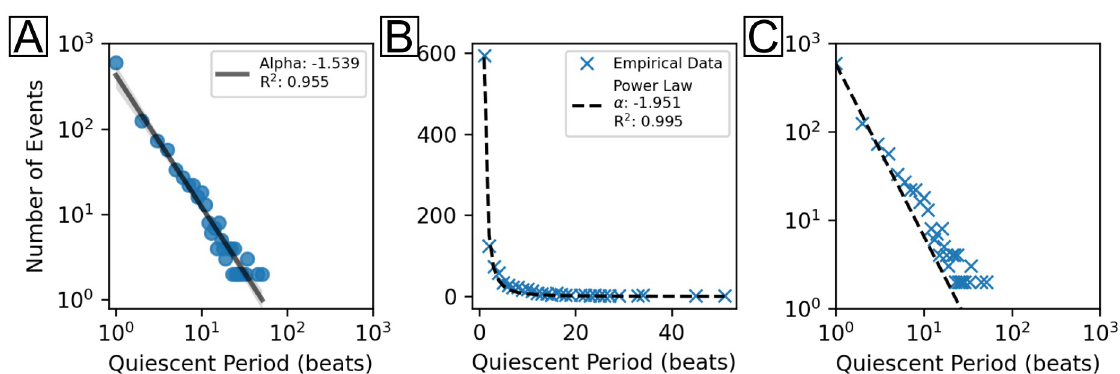
Fig 4. Non-robust power law analysis. A) Log 10 (y) vs log 10 (x) (scatterplot, blue), where y is the number of events and x is the quiescent period between translocations as measured in the number of beats between. Linear regression of the data (solid line, black) yielded α = -1.539 and R 2 = 0.955. The confidence interval (0.95) of the linear regression fit is shown in gray shading. Number of unique data points, N: 30. B) Nonlinear least squares fit to a power law function (dashed, black) with the calculated α = -1.951 and R 2 = 0.995. C) Log-log axis visualization of B.